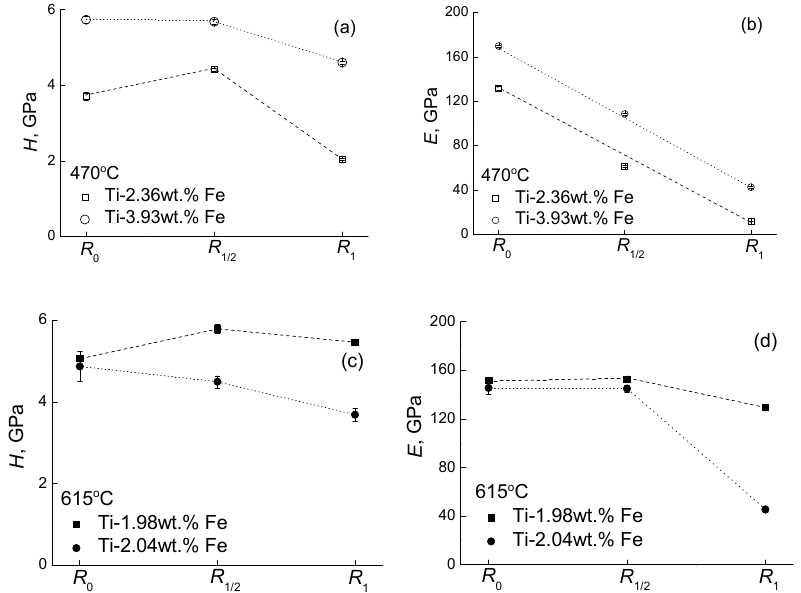
Figure 5. Values of nanohardness and Young’s modulus measured after HPT in the center ( R 0 ), in the middle of the radius ( R 1/2 ) and at the edge ( R 1 ) of the samples for the alloys: ( a , b ) Ti–2.36 wt.% Fe and Ti–3.93 wt.% Fe preliminarily annealed at 615°C; ( c , d ) Ti–1.98 wt.% Fe and Ti–2.04 wt.% Fe, preliminarily annealed at 470 °C.